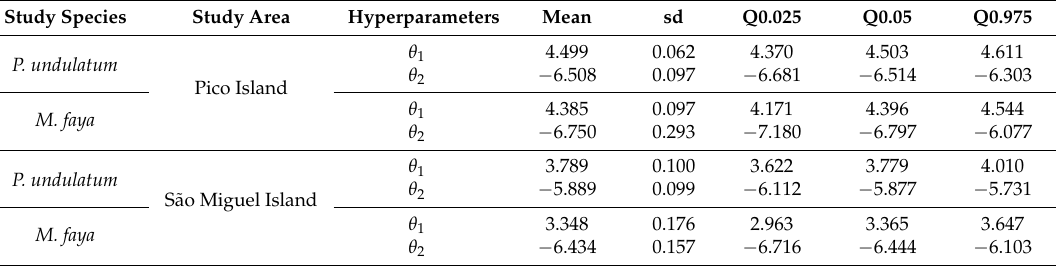
Table 8. Random field hyperparameters for the best model selected (EGV set